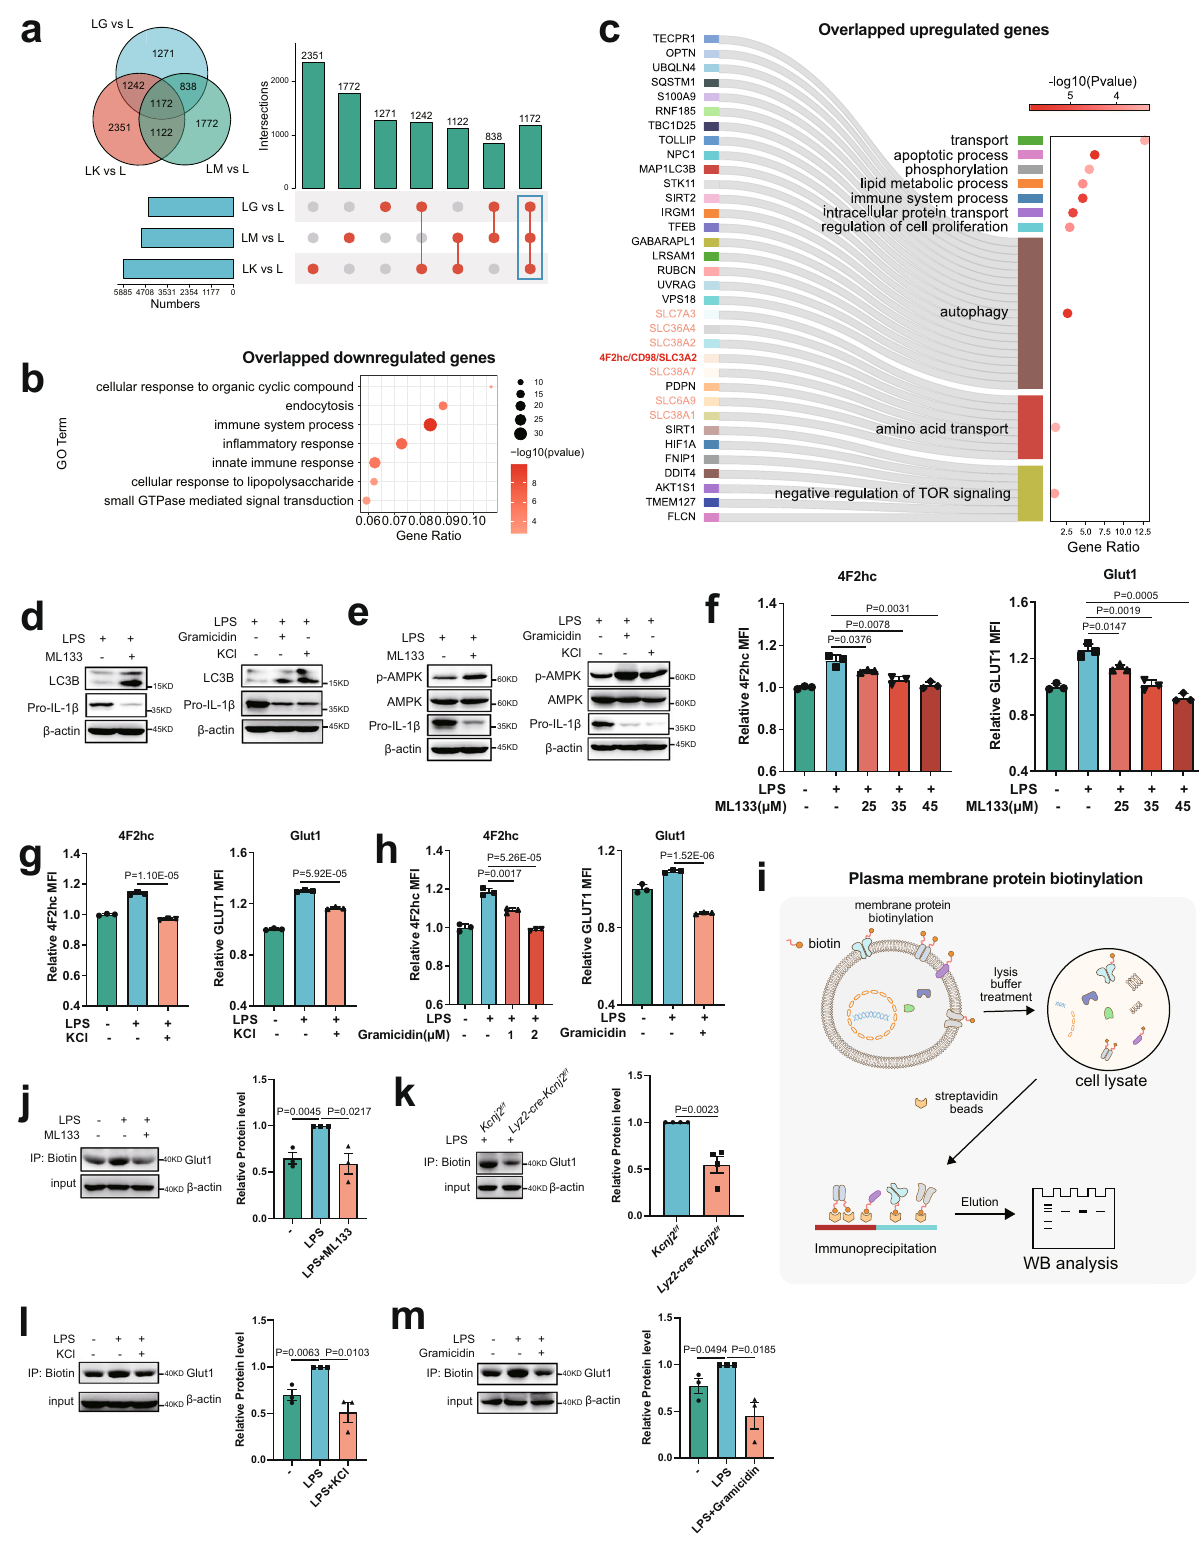
Reagents . LPS from Escherichia coli O111:B4, U-[ 13 C]-serine, serine, glycine, methionine, and S-(5 ′ -Adenosyl)-L-methionine chloride dihydrochloride (SAM) were from Sigma; ML133 was from Selleck; gramicidin, PA-6, Tram-34, PAP-1 were from MedChemExpress; dialyzed FBS was from Biological Industries; and U- [ 13 C]-glucose was from Cambridge Isotope Laboratories; 2NBDG was from Cay- man; Nystatin was from Sigma; cell permeable Dimethyl 2-Oxoglutarate ( α -KG) was from 9 Ding Chemistry. NATURE COMMUNICATIONS| (2022) 13:3544